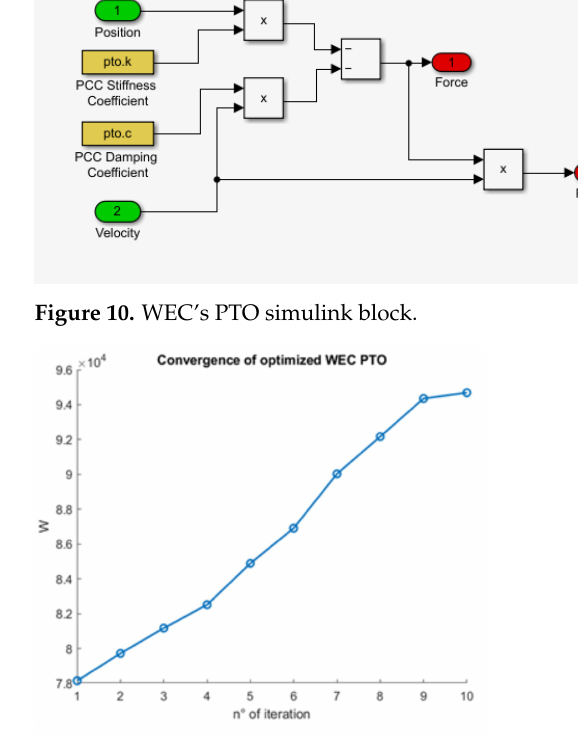
Figure 11. Convergence of the power